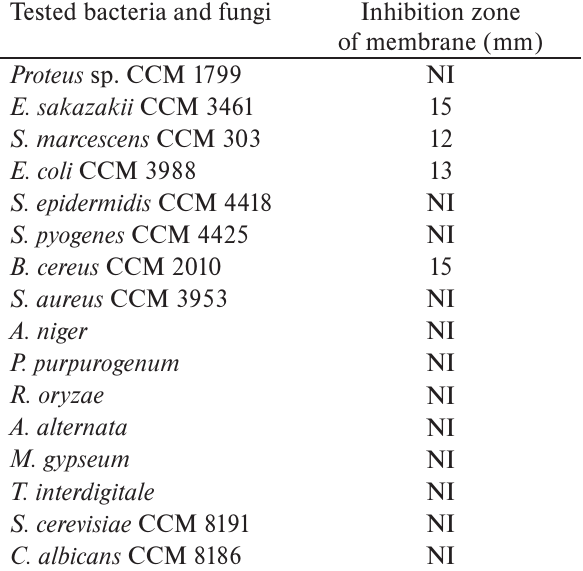
Table 2. Antimicrobial effect of coladerm-beta glucan Table 3. Mutagenic effect of the coladerm-beta glucan membrane. membrane on Salmonella Typhimurium TA98 and TA100 using the Ames test.